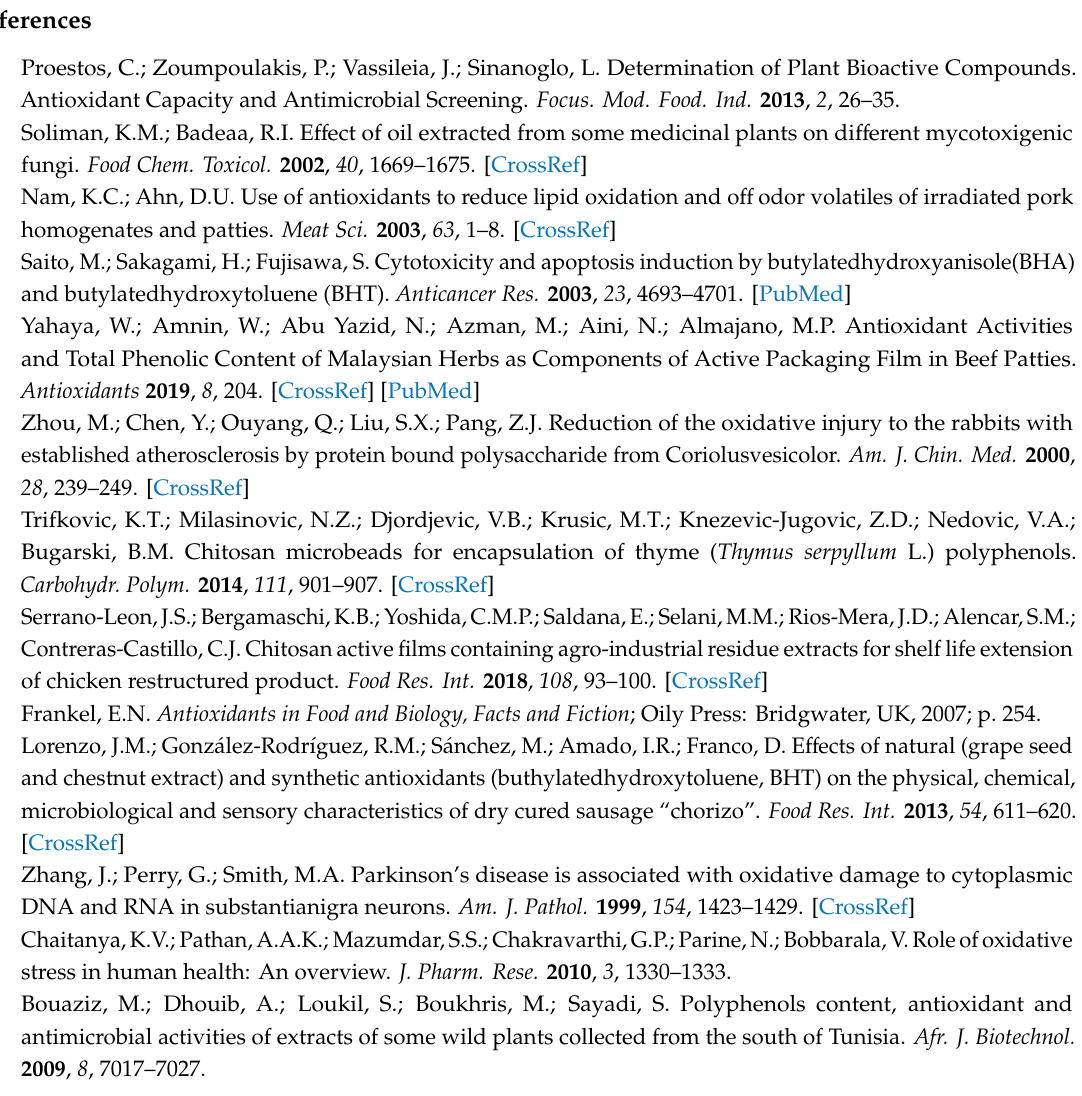
Figure S1: Chromatogram of O. Africana acetone leaves extract, Figure S2: Chromatogram of O. Africana ethanolic leaves extract; Table S1: Correlation between physicochemical and sensory measured variables for beef burger added of OA leaves aqueous extract (Aq) during storage at + 4 ◦ C; Table S2: Correlation between physicochemical and sensory measured variables for beef burger added of OA leaves acetone extract (Ac) during storage at + 4 ◦ C; Table S3: Correlation between physicochemical and sensory measured variables for beef burger added of OA leaves ethanol extract (Et) during storage at + 4 ◦ C; Table S4: Correlation between physicochemical and sensory measured variables for beef burger added of commercial mix (( + ) control) during storage at + 4 ◦ C; Table S5: Correlation between physicochemical and sensory measured variables for beef burger during storage at + 4 ◦ C ((-)